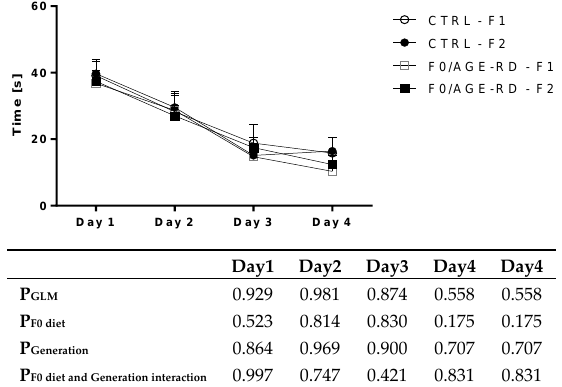
Figure 6. Performance of males in the Morris water maze – latency to find a platform. CTRL, offspring of F0 dams consuming standard chow; AGE-RD, offspring of F0 dams consuming a diet rich in advanced glycation end products; F, generation; GLM, general linear model; values are presented as mean + standard error of the mean.